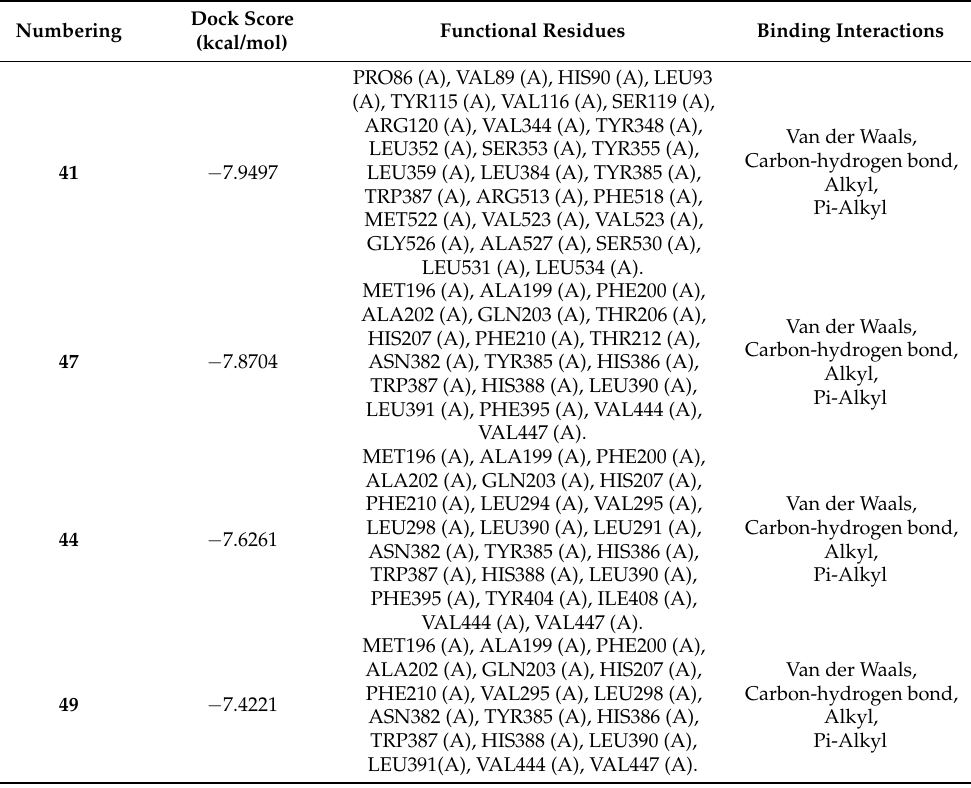
Table 5. Summary of molecular docking results of top 4 dock score compounds with the COX-2 target